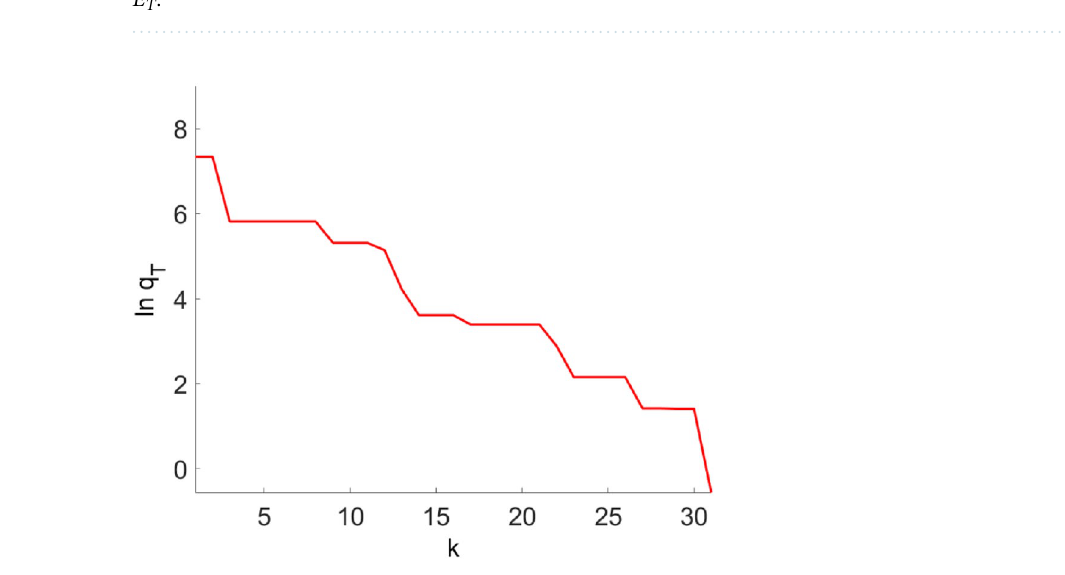
Figure 2. The fitting process of three key parameters of the TC model in Parkinson’s state. ( a ) I Gi → Th ( b ) g T ( c ) E T .